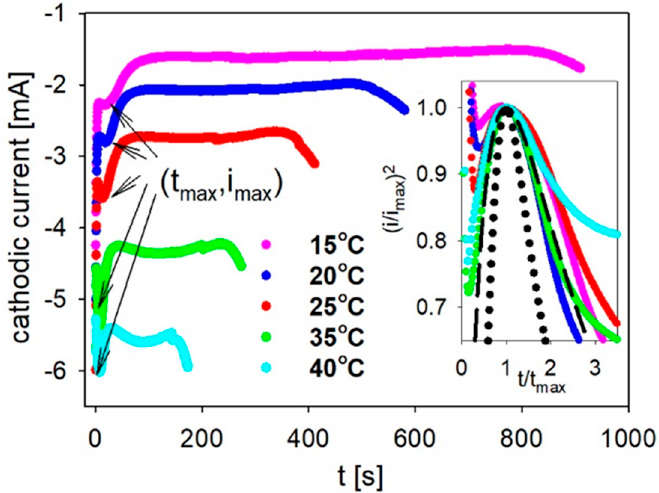
Figure 2. The cathodic current density versus the time measured during the deposition of the Fe nanowires that were prepared at different electrolyte temperatures. The inset shows the dimensionless peaks (derived from the current transients) with theoretical curves for an instantaneous (dashed curve) or progressive nucleation (dotted curve).